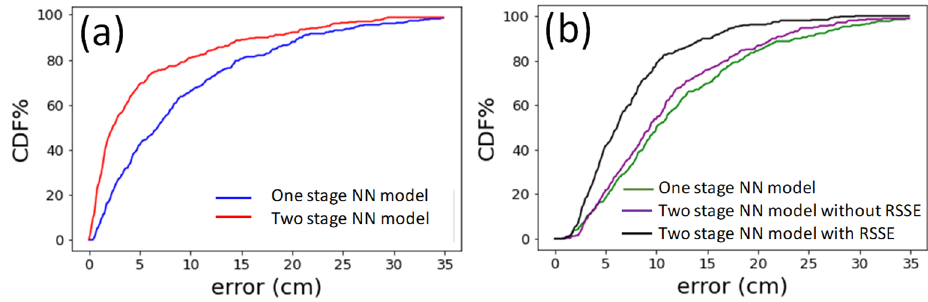
Figure 11. CDF of measured error at ( a ) z -direction ( b ) xy- direction using different NN models.